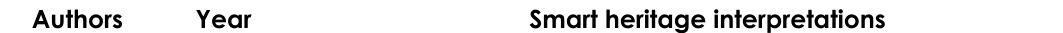
Table 5 . Interpretations of Smart Heritage from Reviewed Articles.